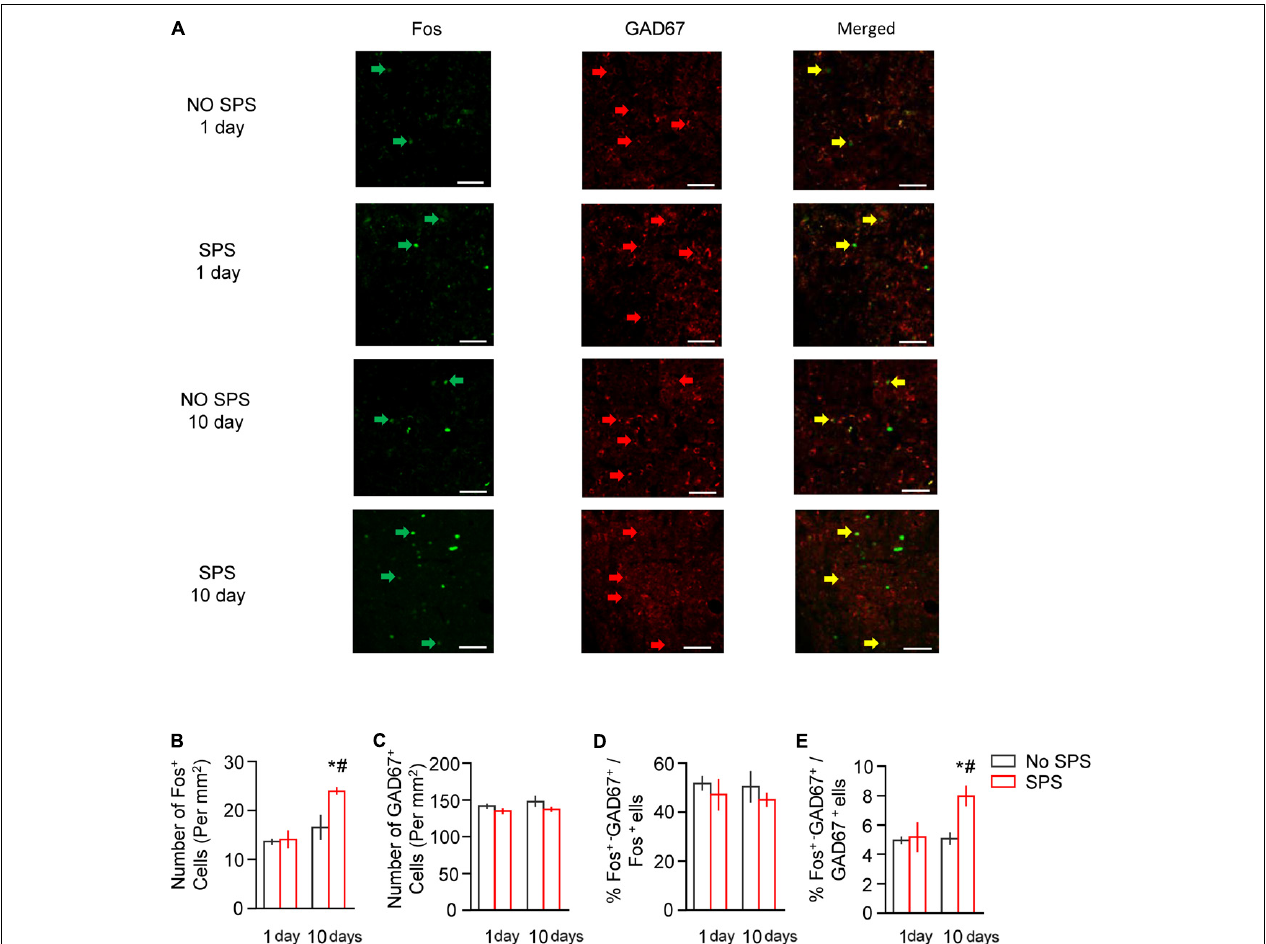
FIGURE 4 | Effect of single prolonged stress (SPS) on activation of GABAergic neurons in CeA on day 1 or day 10 after stress. (A) Representative images showing green (Fos protein), red GAD67 protein), and merged channels of double-label neurons in CeA in different experimental conditions. Scale bars represent 100 µ m. (B,C) Effect of the experimental manipulations on Fos protein (B) and GAD67 expression (C) in CeA. (D) Percentage of GABAergic neurons in activated cells of CeA in different experimental manipulations, as calculated by number of overlap (Fos + GAD67 protein-IR)/Fos-IR. (E) Percentage of activated cells in GABAergic neurons of CeA in different experimental manipulations, as calculated by number of overlap (Fos + GAD67 protein-IR)/GAD67-IR. n = 7–8 per group. Data are mean ± SEM. ∗ Different from no SPS group at each post-stress day. # Different from SPS-1 day group, one-way ANOVA, p <